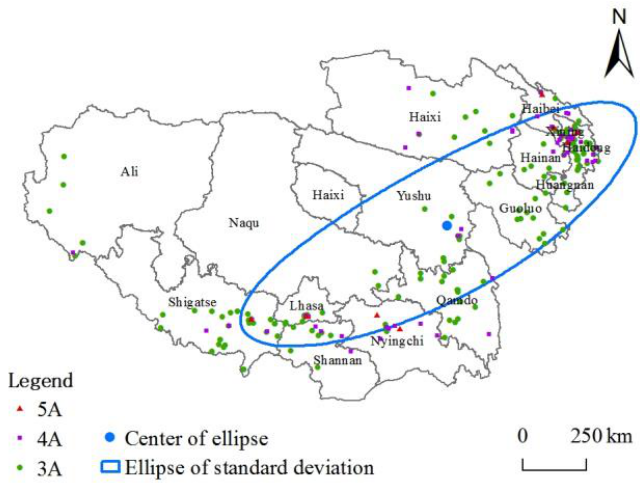
Figure 3. Standard deviation characteristics.